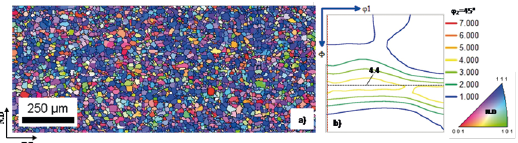
Figure 7. Micro-texture after 50% cold rolling and annealing: a) orientation map; b) ϕ =45° ODF 2